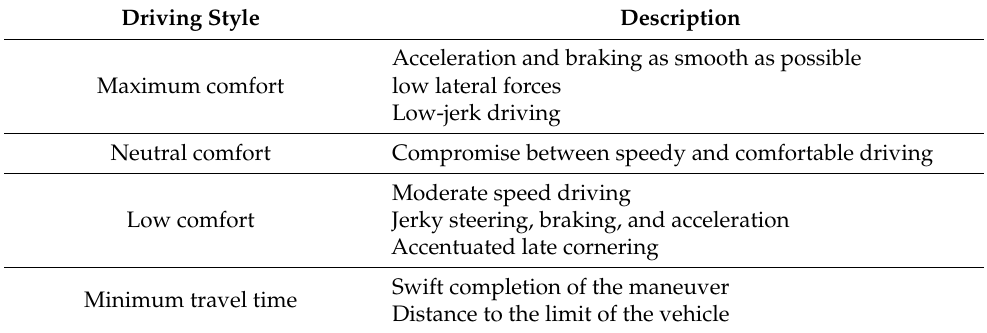
Table 2. Driving styles used for the user